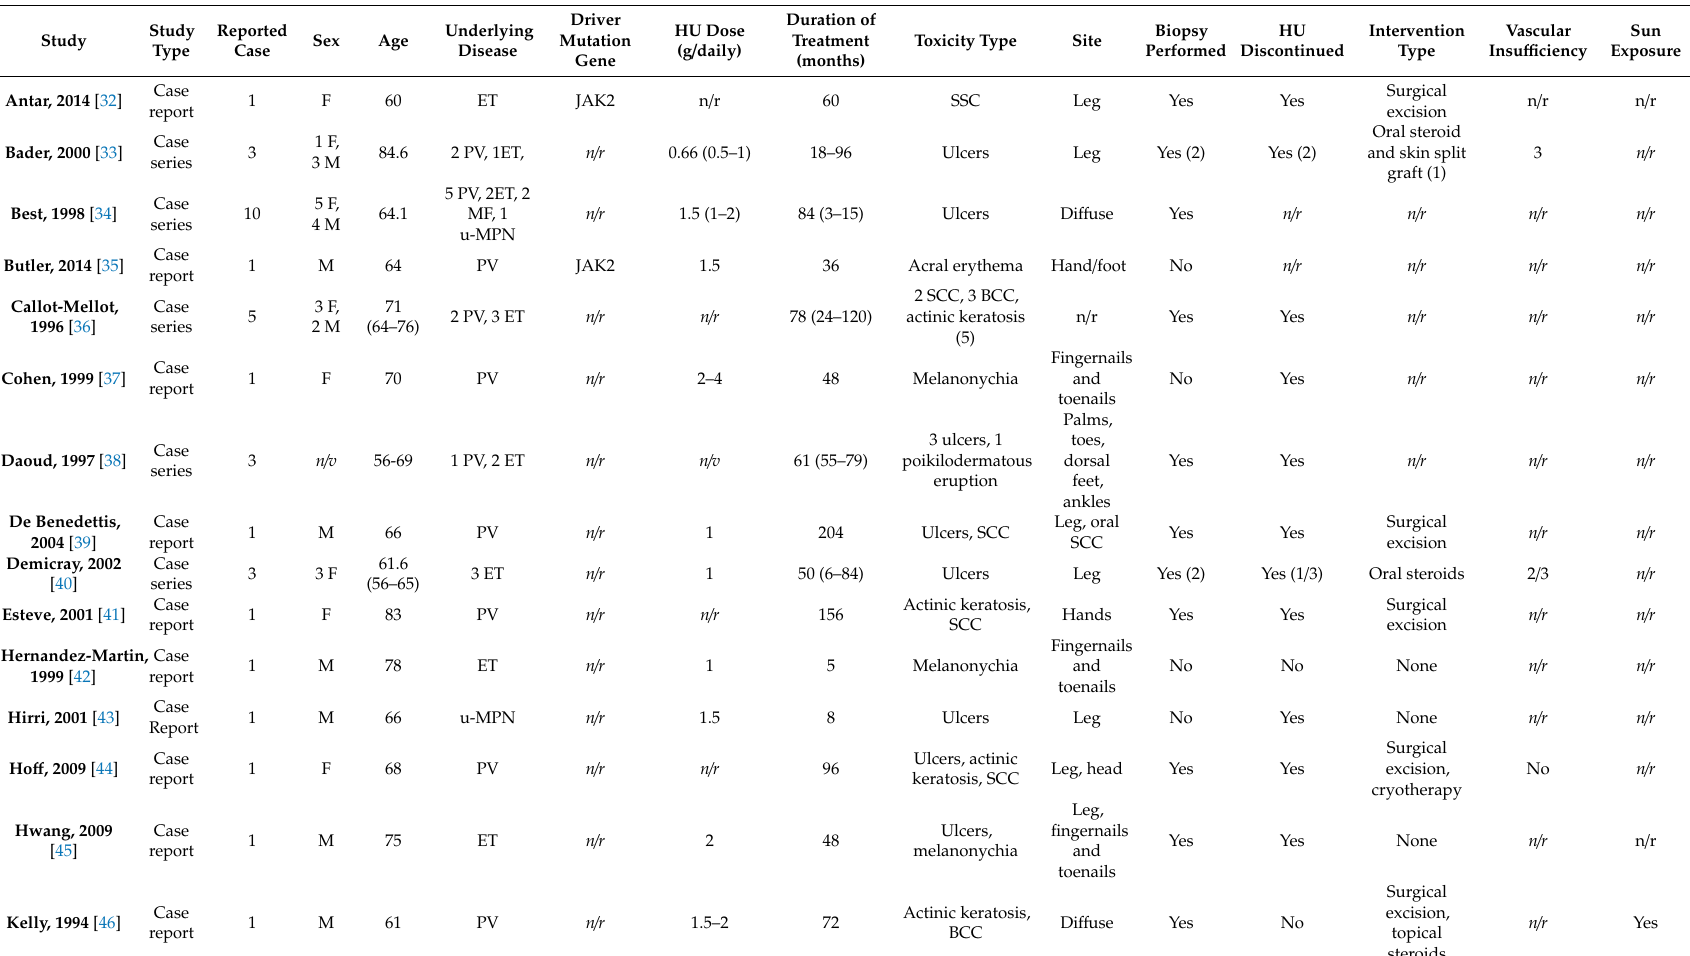
Table 2. Reported cases of hydroxyurea-induced cutaneous